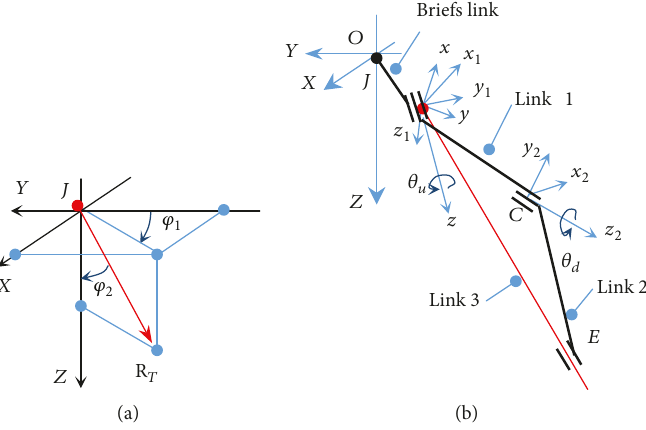
Figure 7: Mechanism models of (a) thigh and (b) hip joint